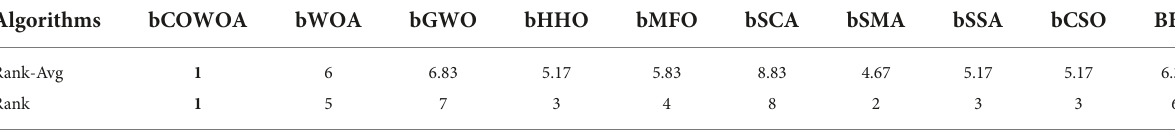
TABLE 18 Average classification precision ranking.